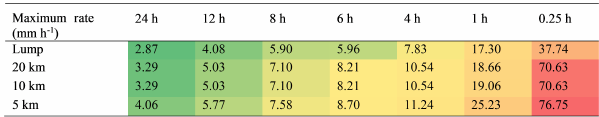
Table 4. Maximum rainfall intensities from the 10-year record for each resolution, taken from the domain for the complete Swale